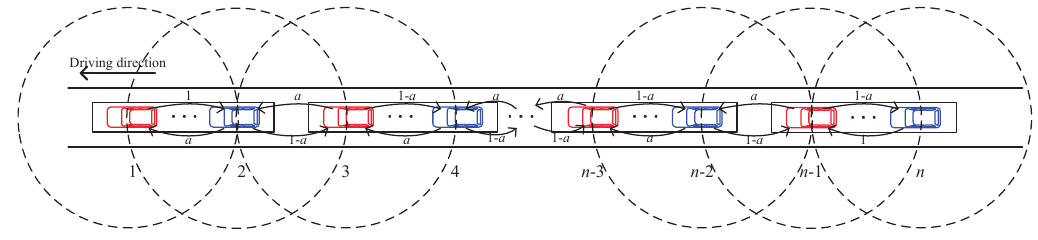
Figure 2. Inter-platoon communications